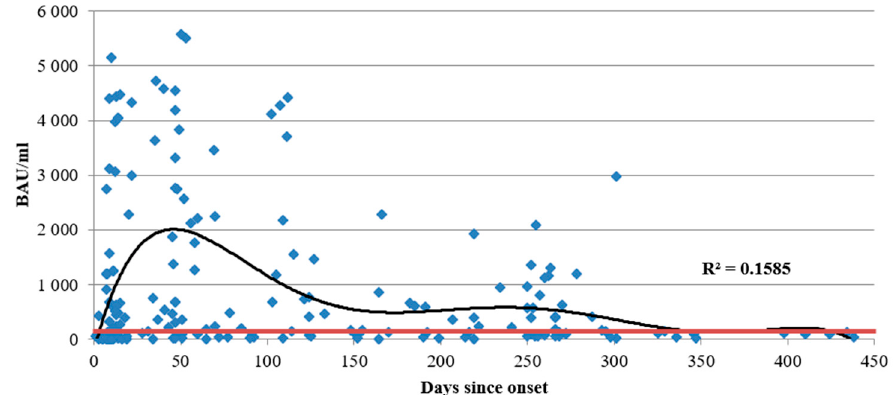
Figure 1. Total anti-N protein antibody dynamics (quantitative ELISA) as a function of time since COVID-19 onset for 348 individual patients. The range was from 1 to 438 days. IgG concentration is presented in BAU/mL. The red dotted line represents the cut-off value for this specific ELISA kit (17 BAU/mL). The black line is the trend (r 2 = 0.16).